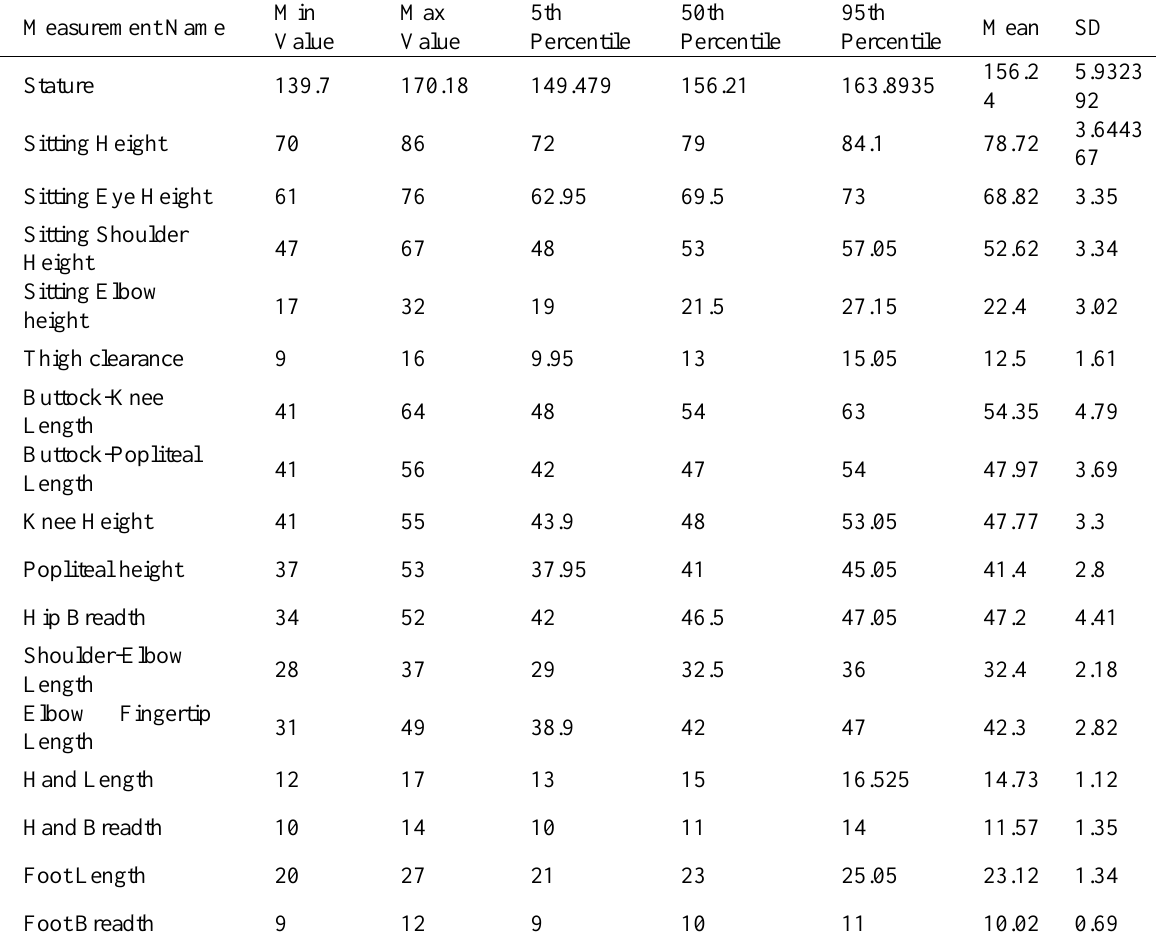
Table 3. Statistical approach for the anthropometric measurement of female official